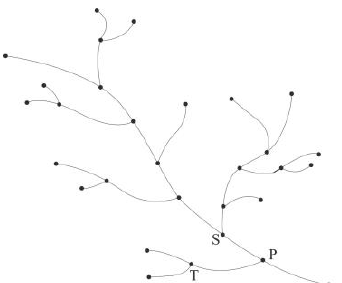
Figure 3. The construction of stroke connections